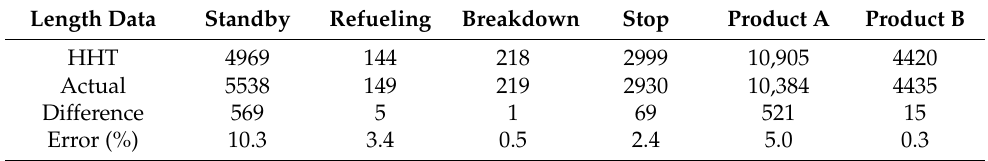
Figure 7. Fast Fourier Transform comparison in different states. ( x -axes: Frequency(Hz); y -axes: Amplitude). Table 1. Segmentation error obtained by Hilbert–Huang Transform (HHT) method.